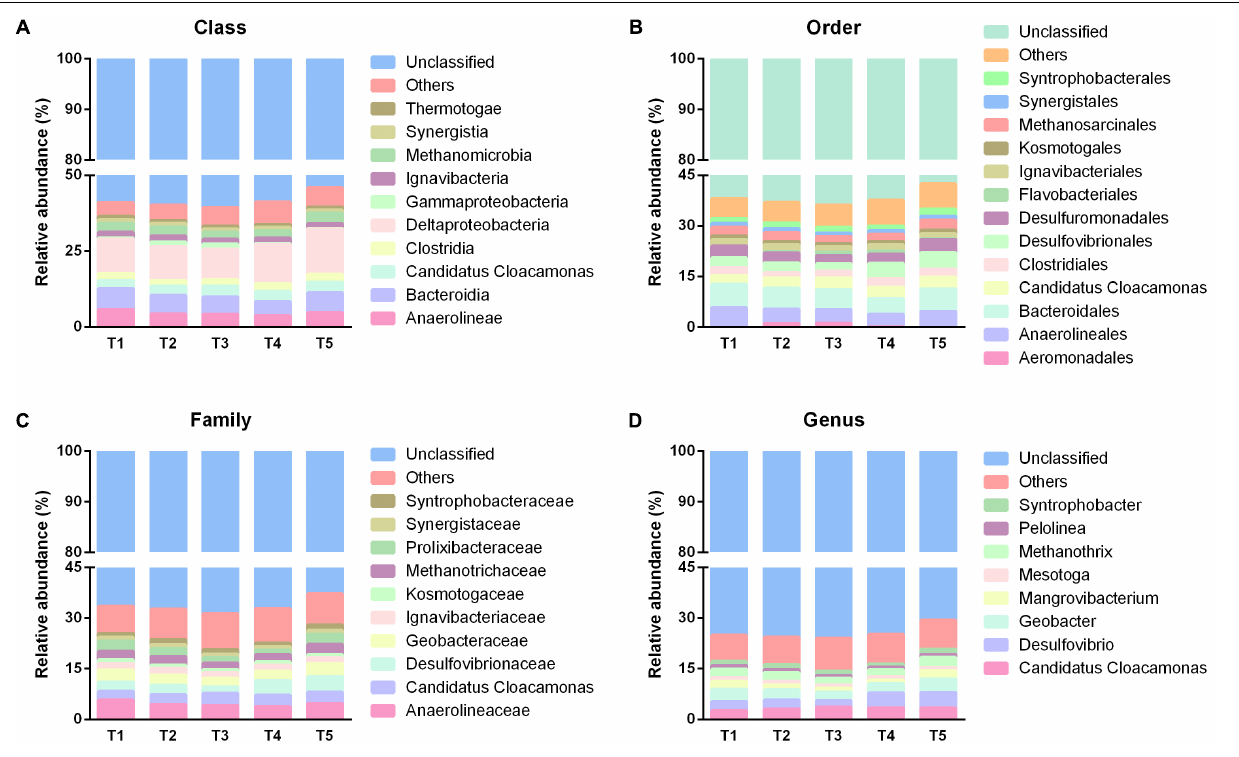
FIGURE 7 | Taxonomic distribution of different time points from class to genus. (A–D) Were the taxonomic information of predominant populations in class, order, family and genus level, respectively.